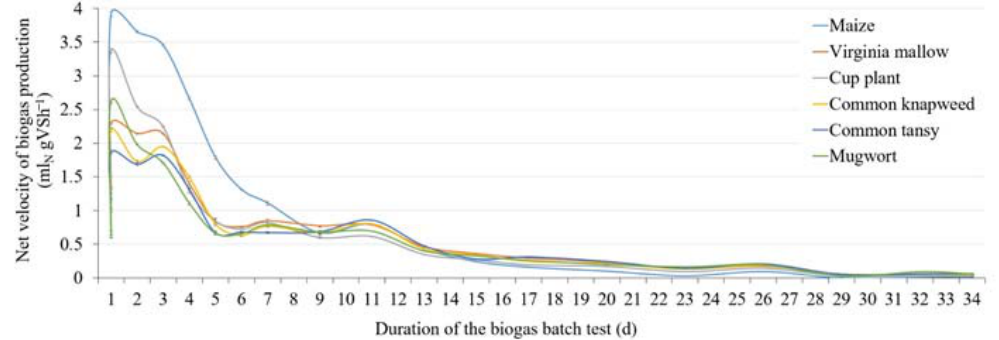
Figure 3. Net velocity of biogas production per gram volatile solids from the crops tested in this study. For each measurement and for each crop except mugwort, the error bars indicate the standard deviation for the replicates of the crop species in the field